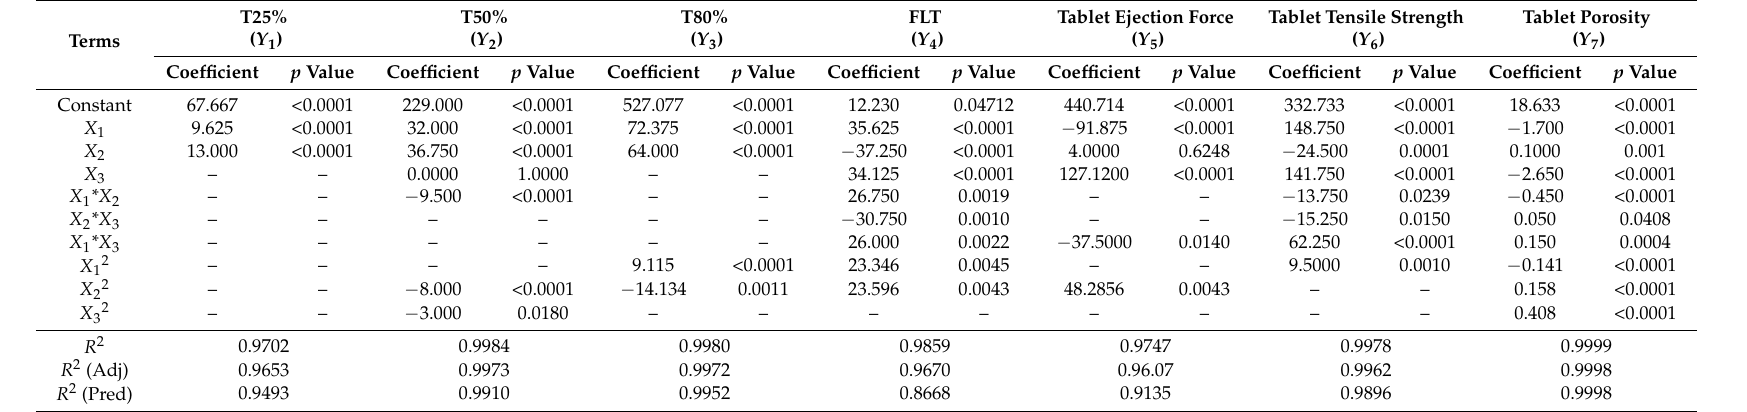
Table 5. Regression coefficients and associated p values for the